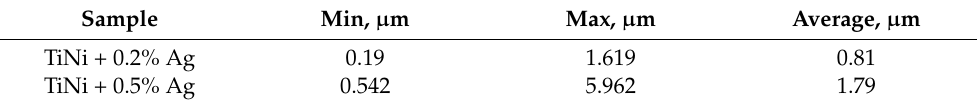
Figure 8. The dependence of the particle size containing silver on the Ag dopant concentration. Table 5. The size of agglomerates of inclusions with silver.